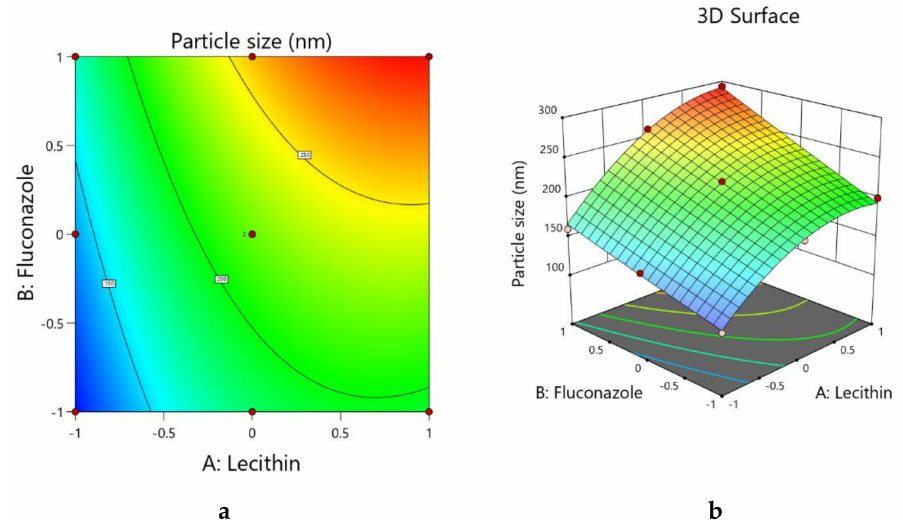
Figure 2. ( a ) Contour plot showing the interactions of lecithin and fluconazole with the globule size of the FS-NTF. ( b ) 3D surface plot showing the interactions of lecithin and fluconazole with the globule size of the